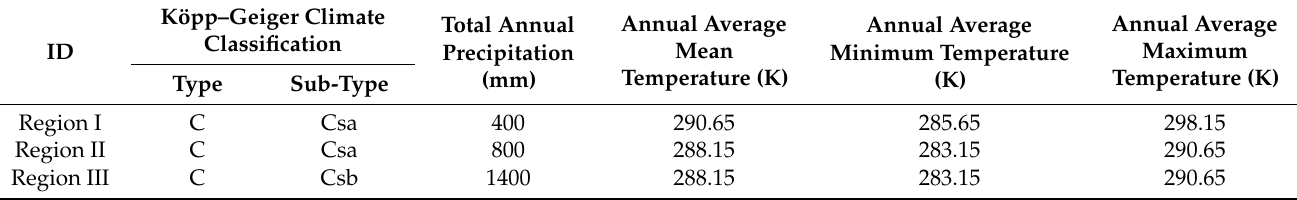
Table 1. Climate data for the giant reed harvesting sites [31].